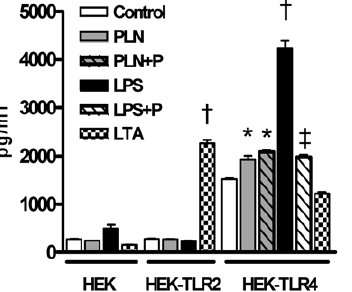
Figure 1. PLN activates HEK cells via TLR4. IL-8 production in HEK- 293 cells transfected with CD14 and either TLR2 or TLR4 were incubated with medium (control), LPS (100 ng/ml), LTA (5 m g/ml) or PLN (1 m g/ml) for 6 hours. In some experiments polymyxin B (P) was used at 10 m g/ml. Data are mean 6 SEM (N=4 per group). * P , 0.01 versus control, { P , 0.001 versus control, { P , 0.001 versus